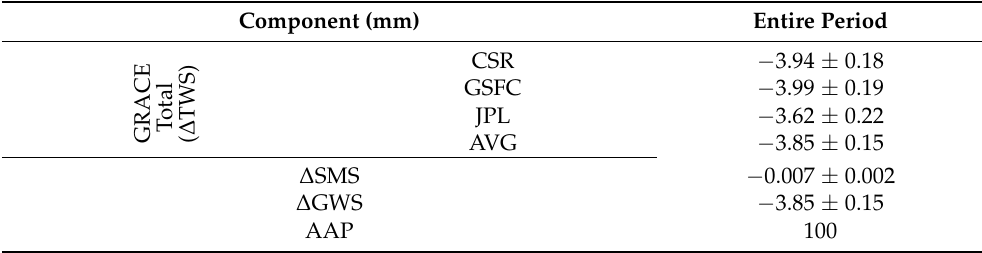
Figure 8. Monthly TWS ( a ) and their mean ∆ TWS ( b ) time series from 04/2002 to 12/2021, produced from CSR, GFCF, and JPL GRACE mascon solutions for the study area. Table 1. ∆ TWS components (mm yr − 1 ) over the entire Makah region at a 95% level of confidence. Component (mm) Entire Period